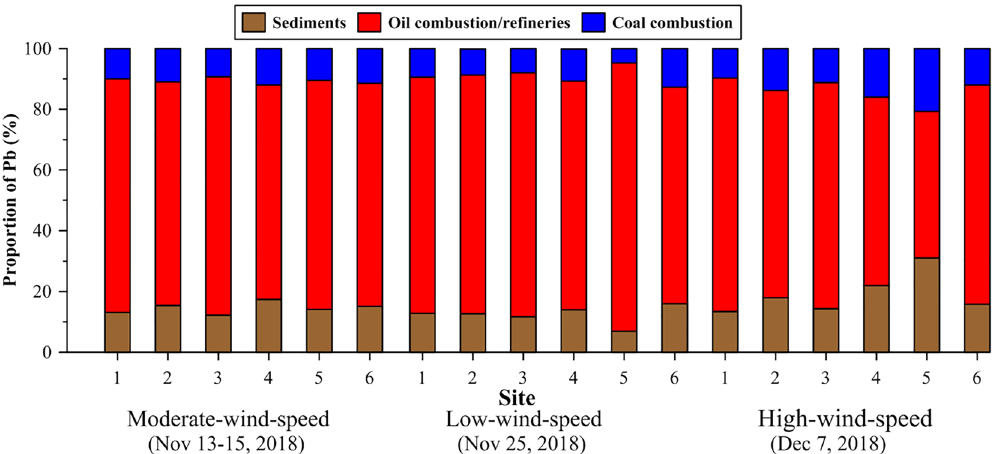
Figure 5. MixSIAR model outputs of the relative contributions (mean value, with the upper and lower bounds being the 2.5% and 97.5% credible intervals, see Supplementary Table S2) from each end-member to Pb in PM 10 at each site during the local